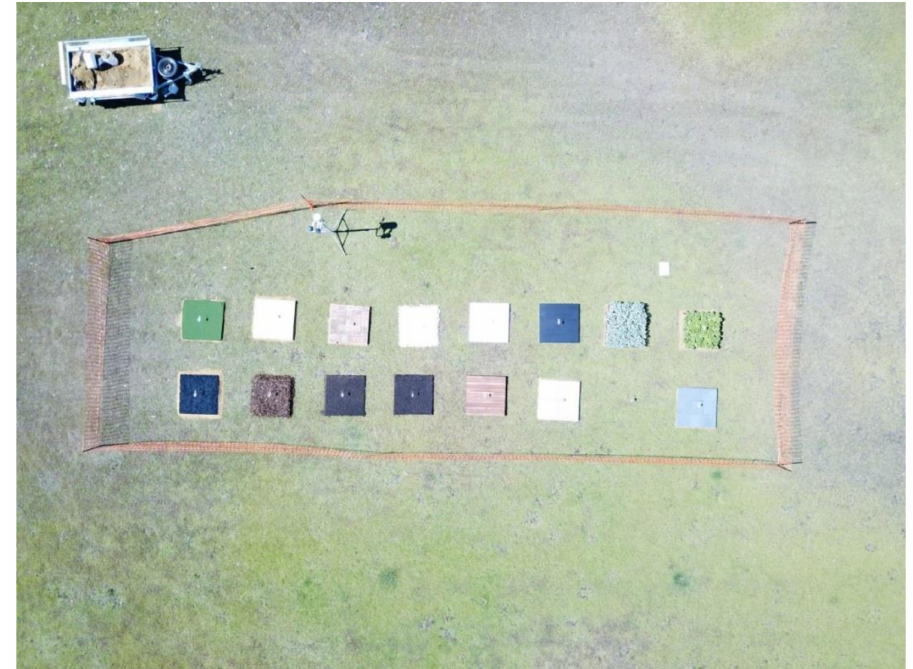
Figure 5. Aerial view of landscape elements on the oval. From top left: artificial grass, pavers (sandstone), pavers (red), crushed rock (white), white painted polystyrene (WPP), black painted polystyrene (BPP), saltbush (native), and petunia (non-native). From bottom left: asphalt, pine bark mulch, soil (dry), soil (wet), decking, concrete, turf grass, and pavers (grey). (Photo courtesy of Grant